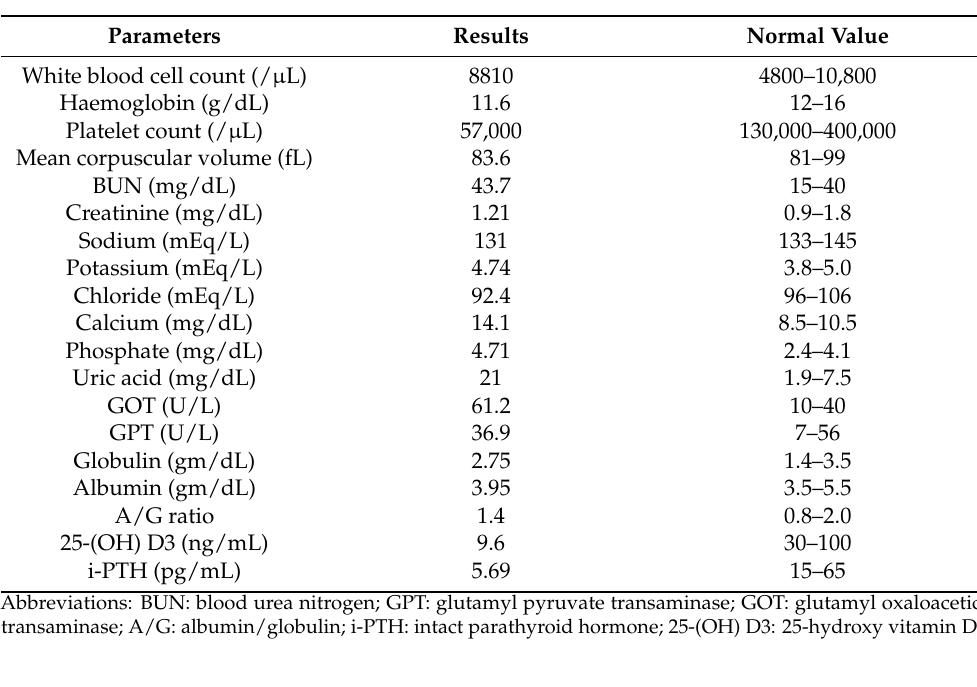
Table 1. Blood biochemistry data.